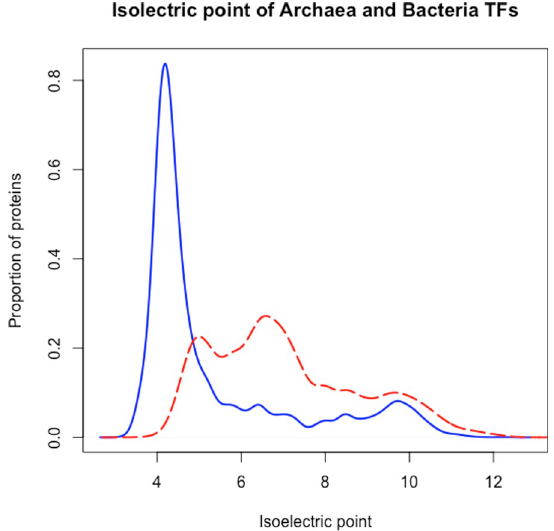
Fig 4. Isoelectric points associated with the TFs in archaea (continuous lines) and bacteria (dashed lines). (Wilcoxon test, p-value < 2.2e-16).